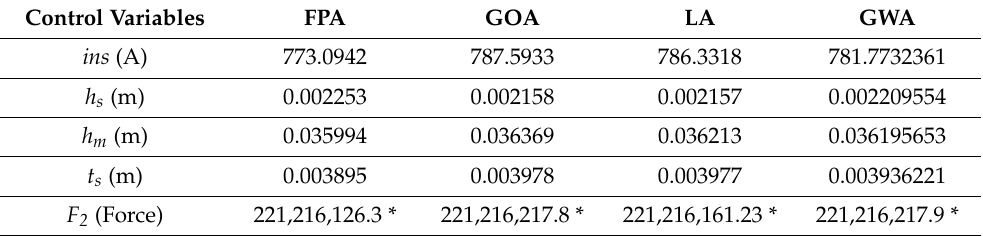
Table 4. Optimal results of the GWA, FPA, LA, and GOA for TLSM design under second case.